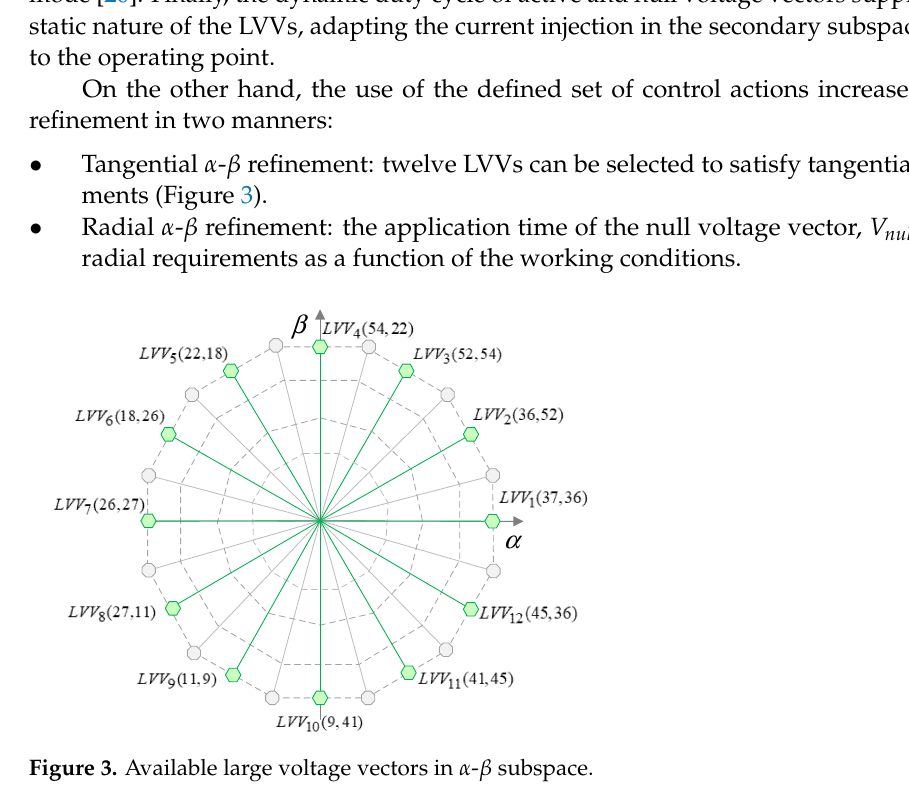
Figure 2 . Voltage vectors in 𝛼 - 𝛽 and 𝑥 - 𝑦 subspaces for an asymmetrical six-phase induction ma- chine fed by a dual three-phase VSC.